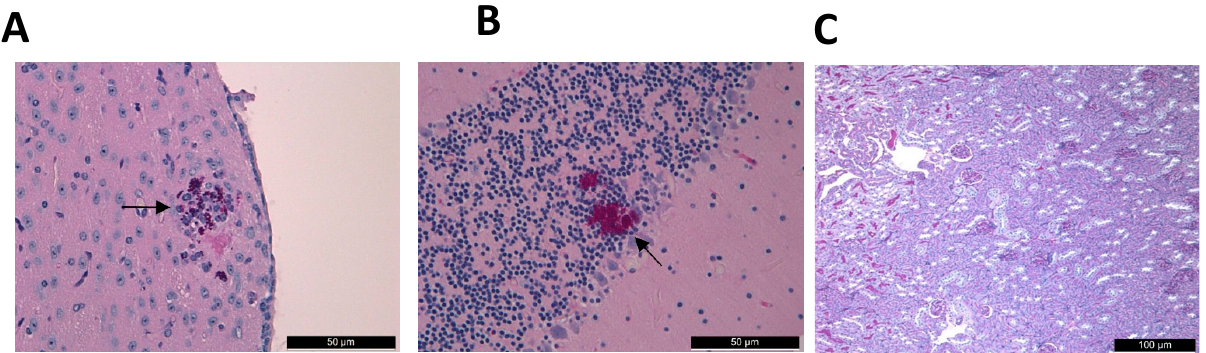
Figure 5. Histopathological examination of the cerebrum, cerebellum and kidney with Periodic Acid Schiff staining from a neutropenic, amphotericin B treated, mice infected with isolate 12,372 (East Asian clade) which died on day 20. The cerebrum ( A ) and cerebellum ( B ) showed yeast cells, but kidneys ( C ) were sterile, with normal histology without fungal cells. Fungal lesions were indicated with black arrows. Magnification, ×100 .